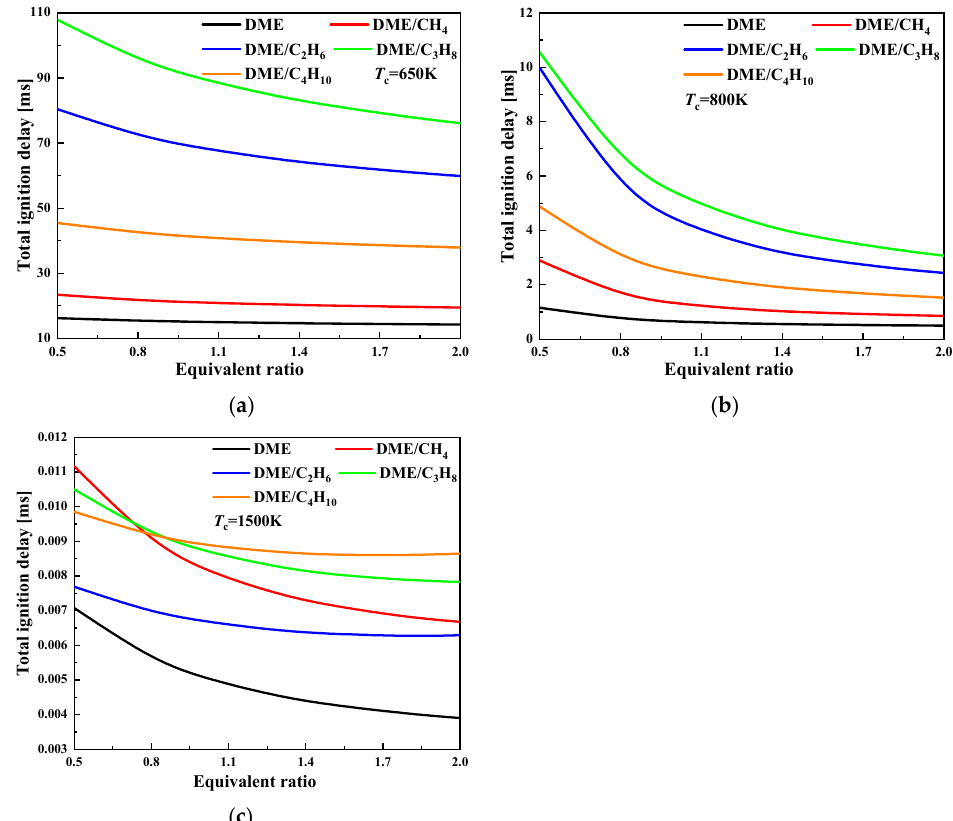
Figure 2. Ignition delay as a function of equivalence ratio for various compressed temperatures at P c = 20 bar: ( a ) T c = 650 K; ( b ) T c = 800 K; and ( c ) T c = 1500 K.